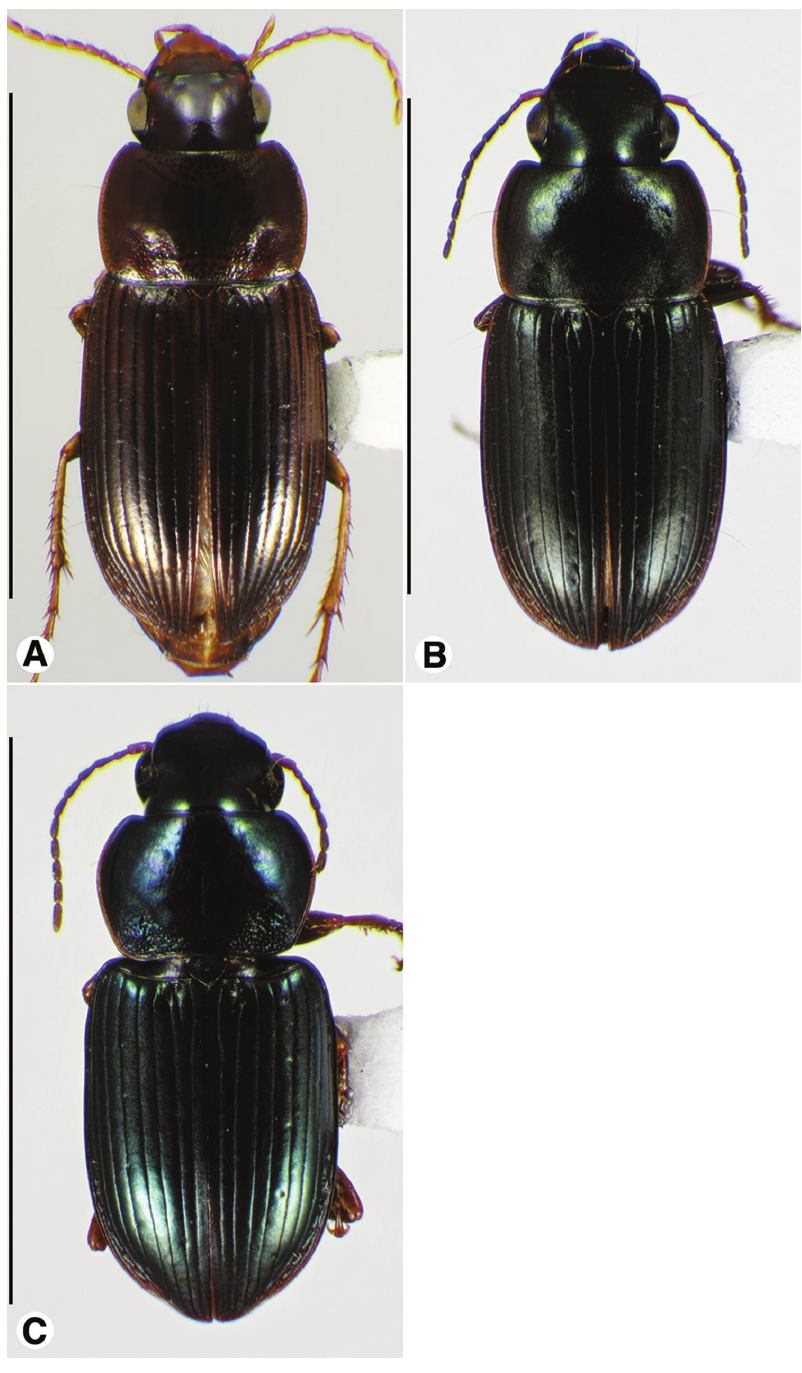
Figure 18. Habitus digital images of Selenophorus latior species group, dorsal aspect. A S. barbadensis Ball & Shpeley B S. latior Darlington C S. solitarius Darlington. Scale bars 5